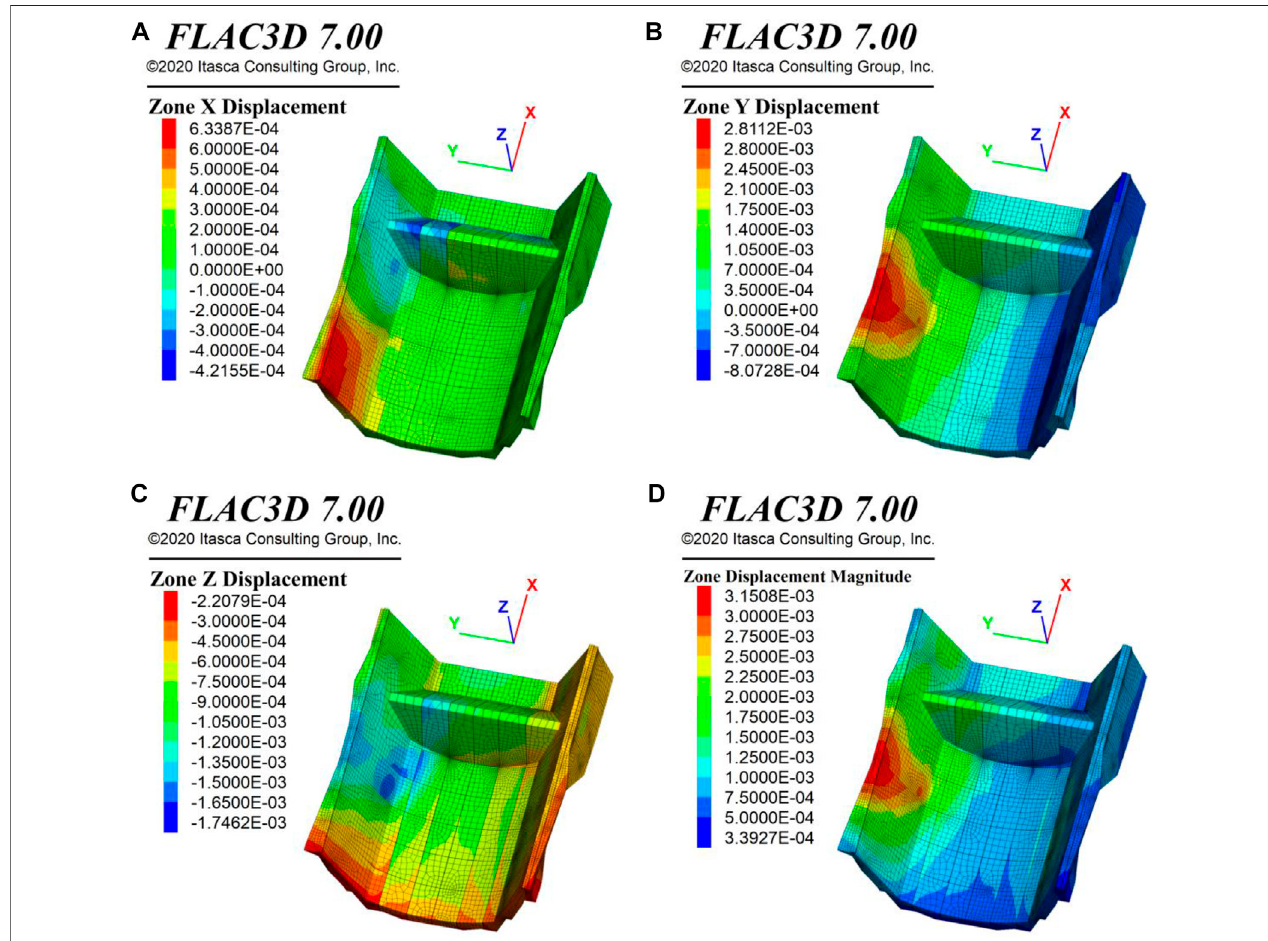
FIGURE 6 | Numerical modelling deformation results of stilling basin for working condition of check fl ood: (A) Xdisp along the river, (B) Ydisp across the river, (C) Vertical displacement, (D) Resultant displacement.